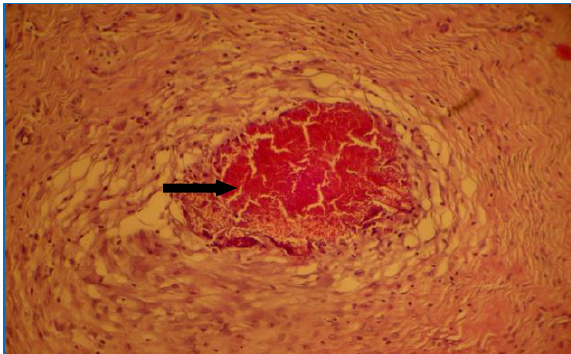
Figure, 9: G6: Liver of rabbit at 20 days post infection show foreign body granuloma contain the destructed parasite in the center ( ) (H and E 10x).